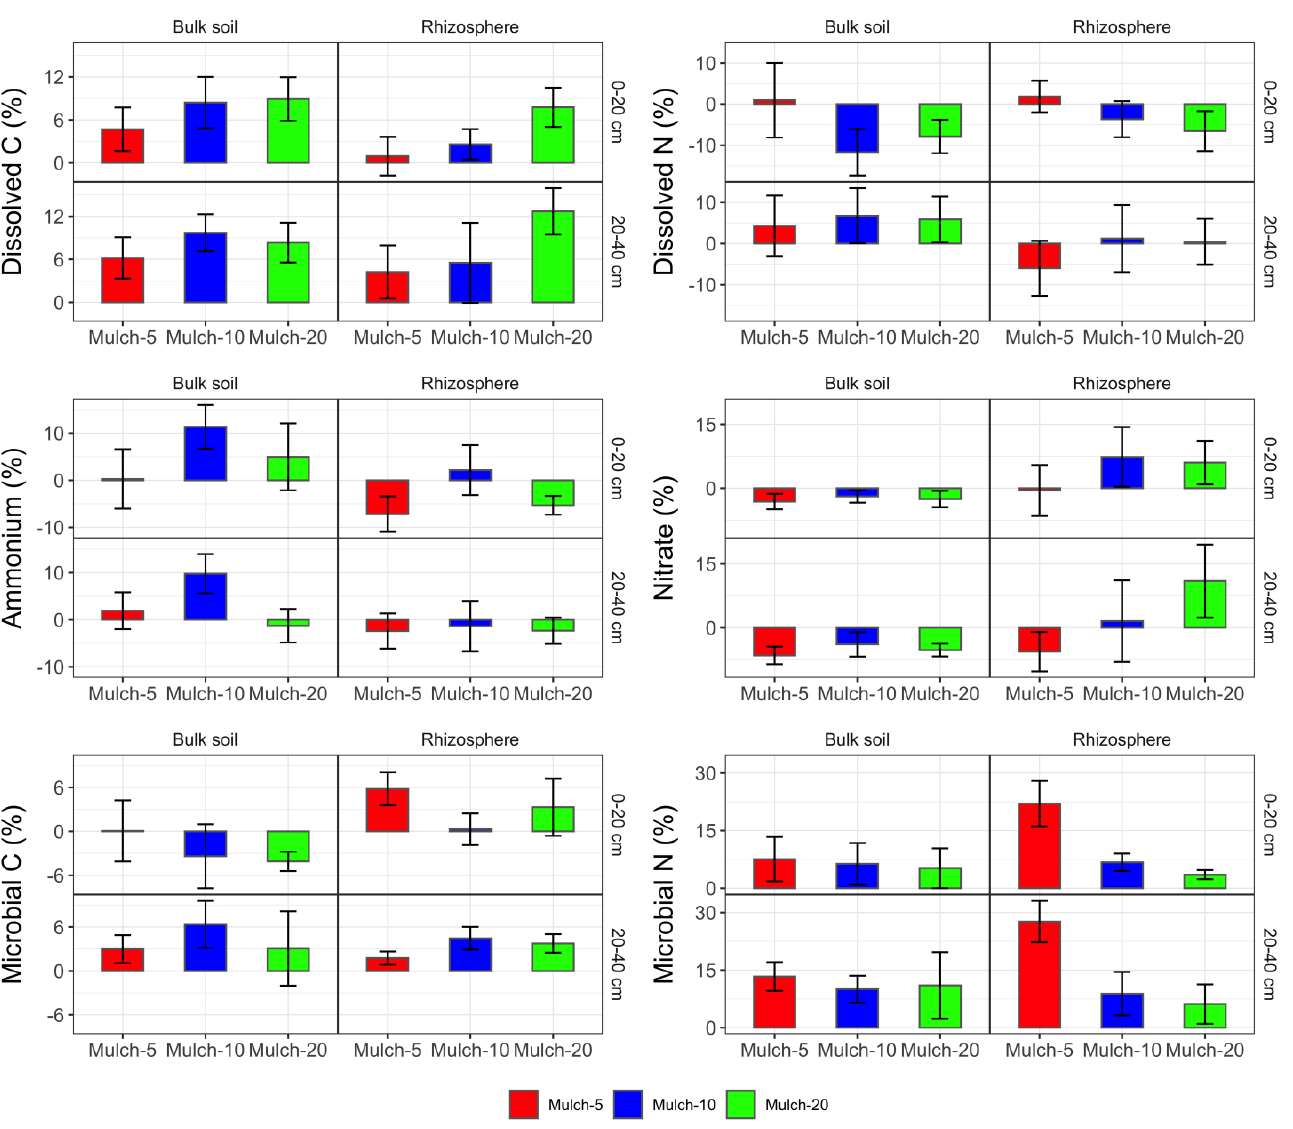
Figure 3. Differences in the C and N fractions between mulching treatments and the control in the rhizosphere and bulk soil. Values represent mean ± standard error ( n = 5). Values above the 0 line indicate C and N content higher in the rhizosphere than in the bulk soil.